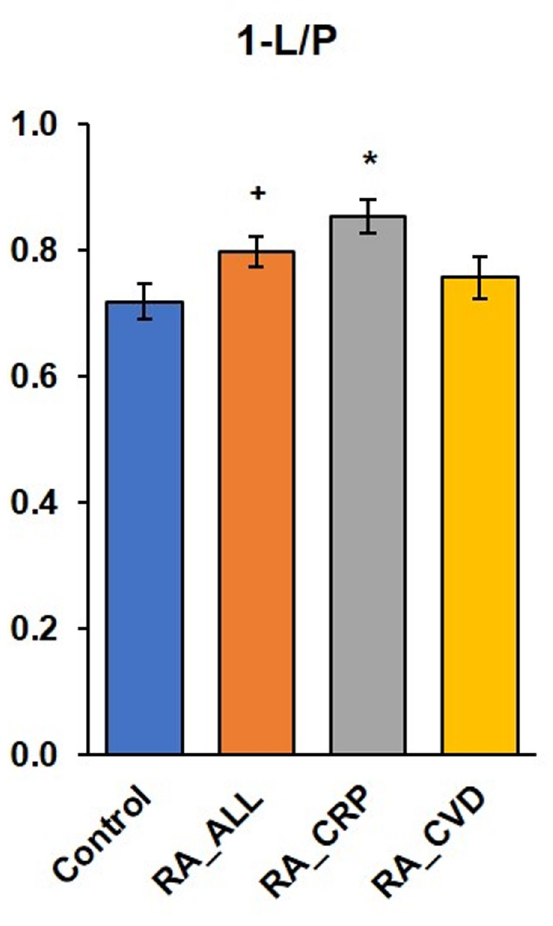
Fig 5. The OXPHOS-coupling efficiency in healthy control volunteers and groups of RA patients. RA_ALL = all patients with rheumatoic arthritis; RA_CRP = rheumatic patients with high c-reactive protein concentration; RA_CVD = rheumatic patients with cardiovascular diseases; + p < 0.5; � p < 0.05 statistical significance vs control group.